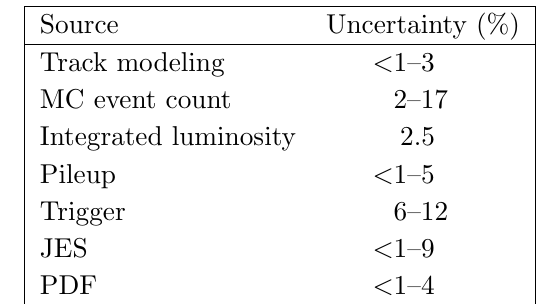
Table 4 . Systematic uncertainties a(cid:11)ecting the background estimate from control samples in data. For the de(cid:12)nition of the selection sets, see table 3.